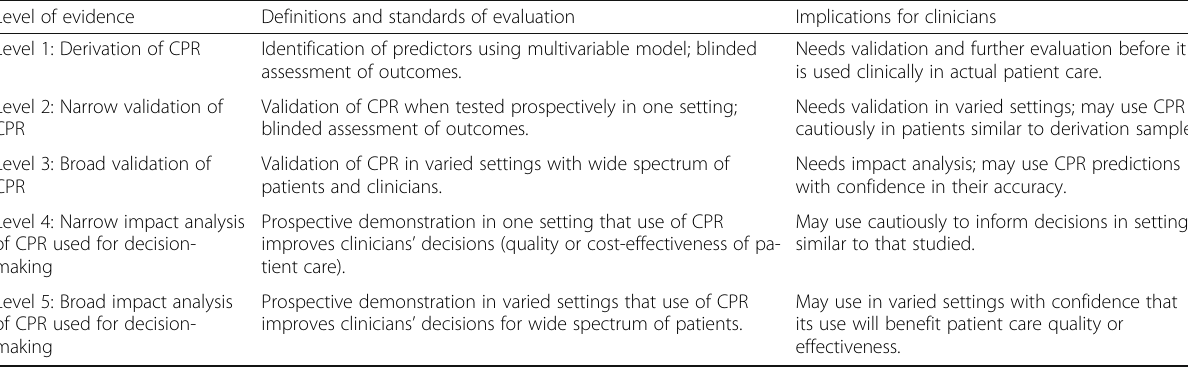
Table 2 Hierarchies of evidence in the development and evaluation of clinical prediction